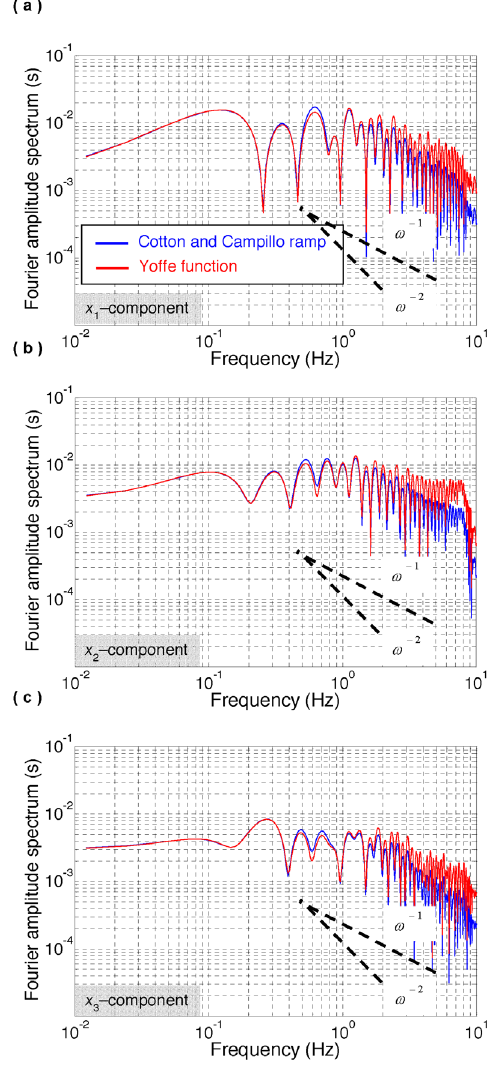
Figure 4. Fourier amplitude spectra (FAS) of the signals reported in Figure 2. (a) FAS( V